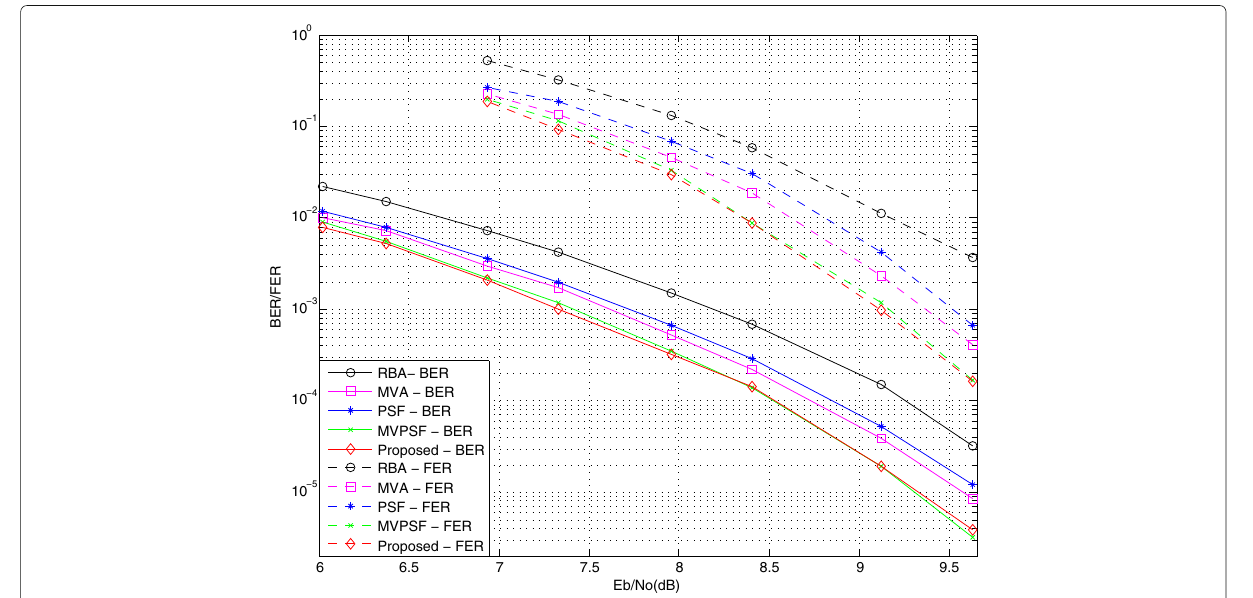
Fig. 2 Comparison of decoder BER performance for 204 × 102, GF(4) LDPC code